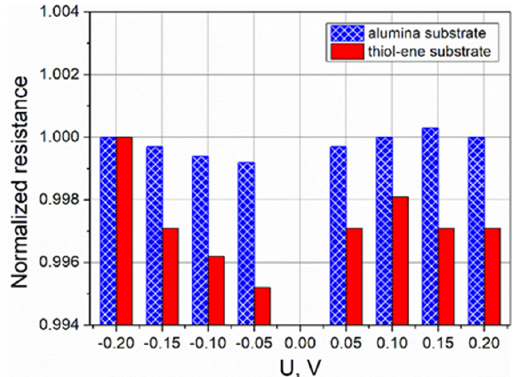
Figure 5. Dependence of resistance on applied voltage for PEDOT:PSS films on alumina and thiol–ene substrates. Histograms are normalized with respect to resistance at − 0.2 V.